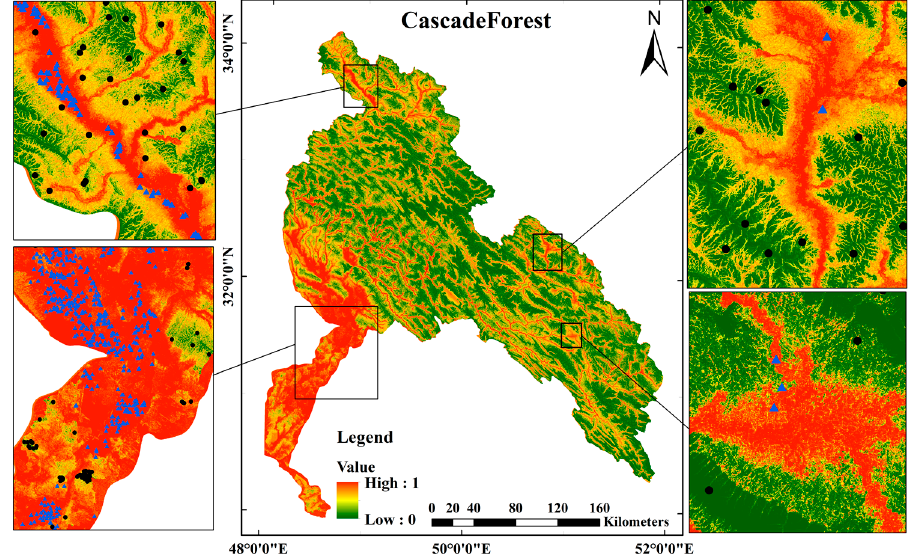
Figure 14. Examples of highly susceptible areas in the Karun basin.